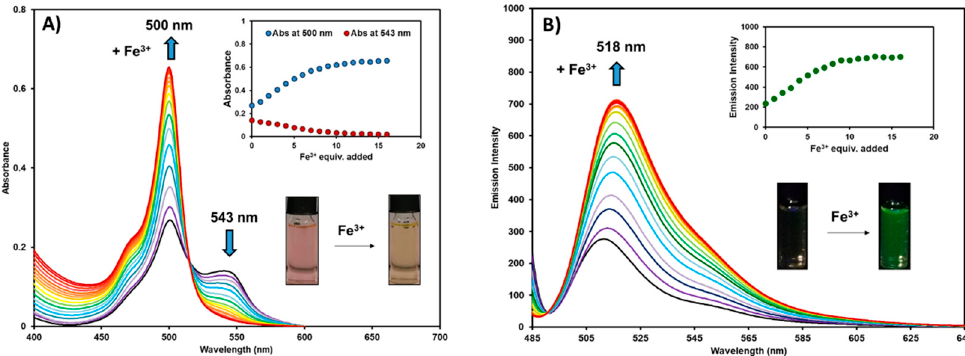
Figure 4. Changes in the absorption spectra of BODIPY-PH ( A ), and emission spectra of BODIPY-PH ( B ) (excitation wavelength = 475 nm) with respect to the increasing of Fe 3+ equivalents (1–16 equiv.) in acetonitrile-water (1:9 v / v ) solutions (Note that, the final concentration of BODIPY-PH was fixed to be 10 µM).